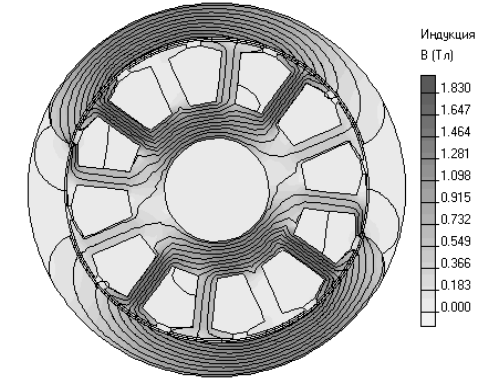
Fig. 9. Picture of magnetic field of the new design SynRM with segment- shaped outer rotor at ε =54 deg.